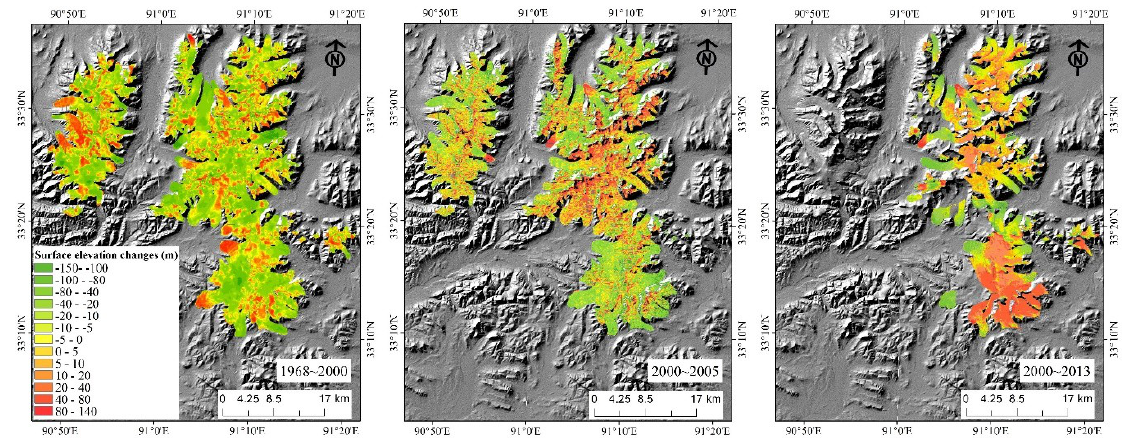
Figure 9. Changes in glacial surface elevation from 1968–2013.